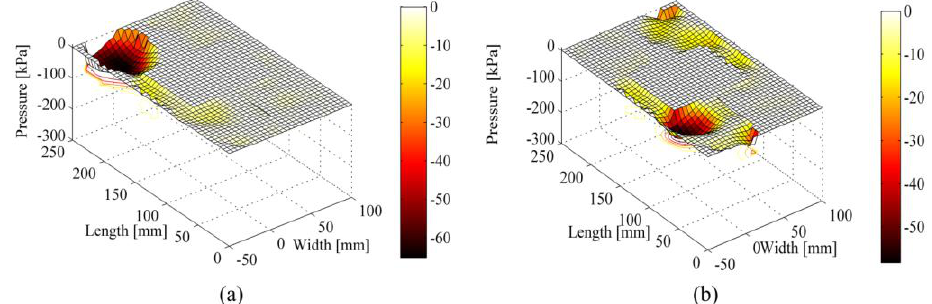
Figure 7. Pressure maps under the foot at different gait phases. ( a ) Weight-acceptance phase of the right foot. The weight is distributed on the heel region. The left foot is swinging; ( b ) Push-off phase of the right foot. The weight is distributed on the right forefoot. The left foot is starting to contact the ground.